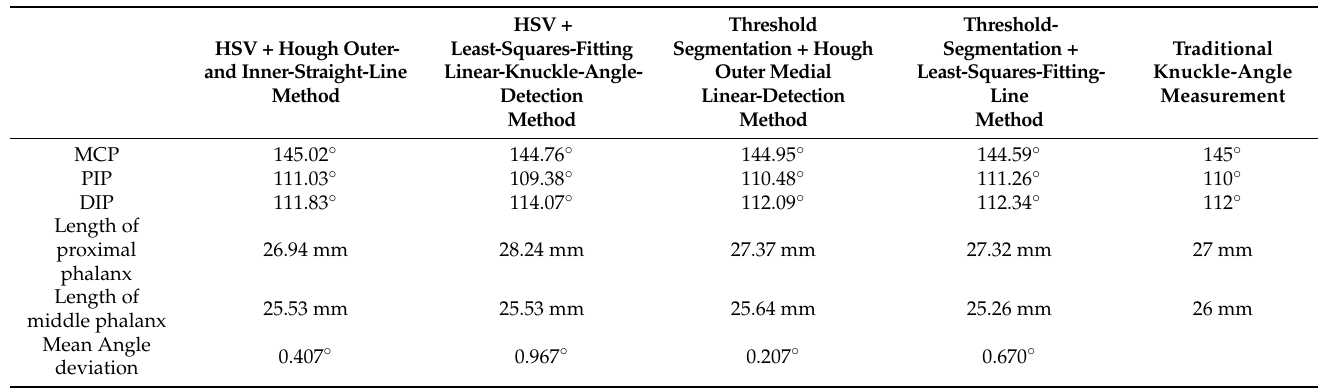
Table 1. Finger-joint angles measured by different methods.